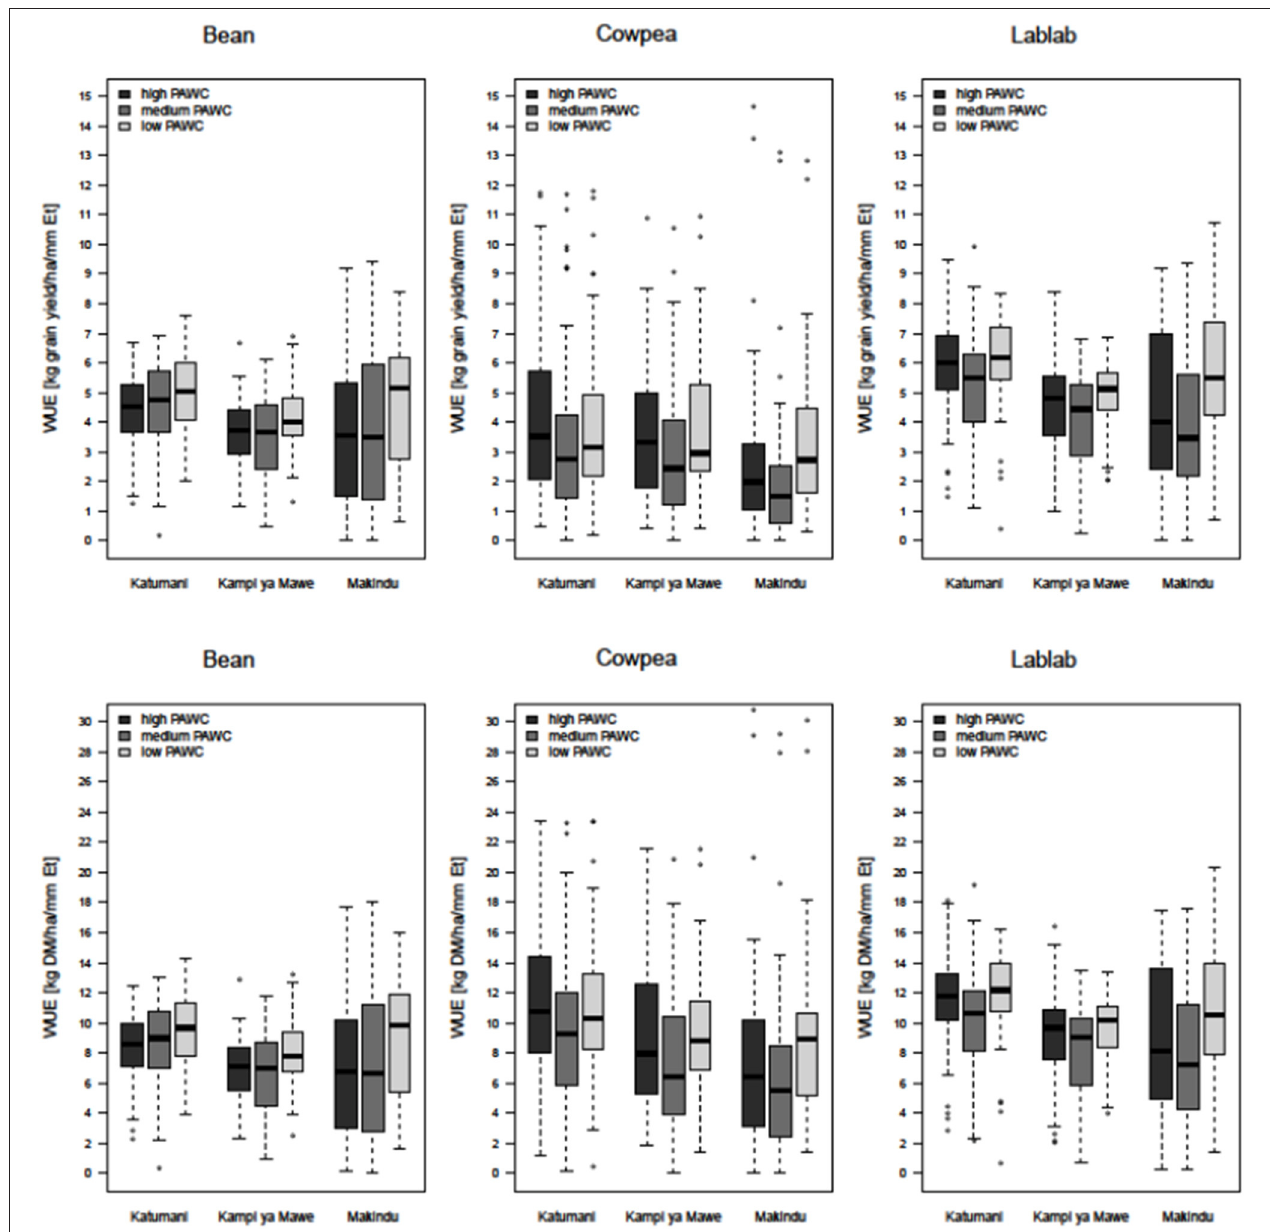
FIGURE 5 | Boxplots of simulated long-term average water-use efficiency (top: kg grain yield ha − 1 mm − 1 E t ; bottom: kg DM biomass ha − 1 mm − 1 E t )for common bean, cowpea, and lablab at different rainfall regions (Katumani, Kampi ya Mawe, and Makindu) for different soils (high plant available water capacity (PAWC), medium PAWC, low